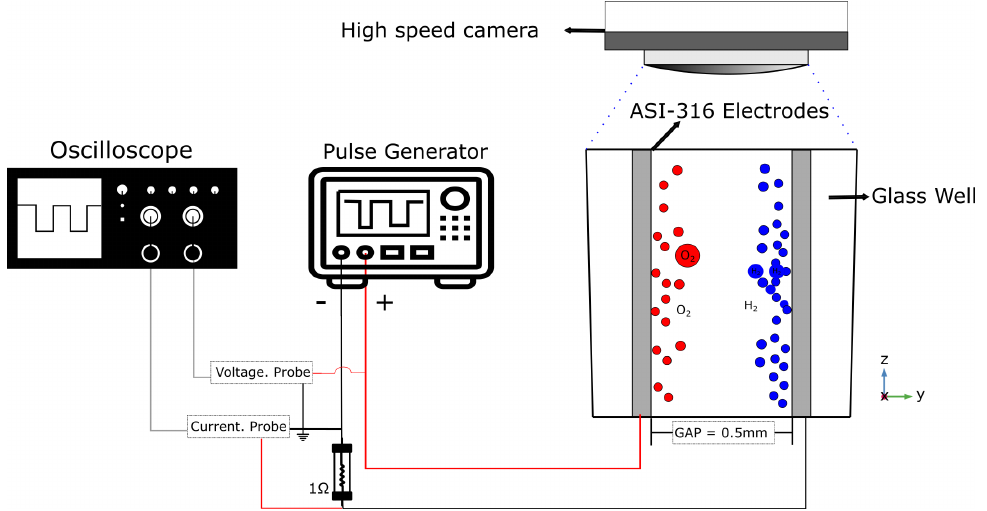
Figure 1. Microwell electropermeabilization setup.